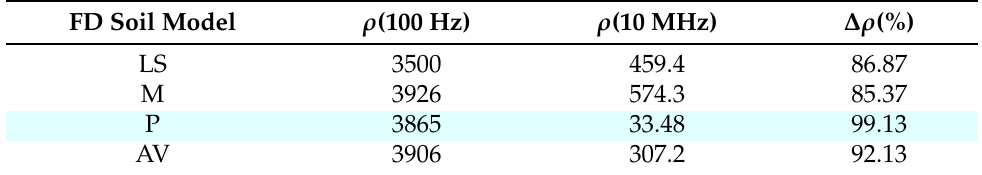
Table 3. ∆ ρ ( % ) for the FD soil models considering the soil of ρ 0 of 4000 Ω